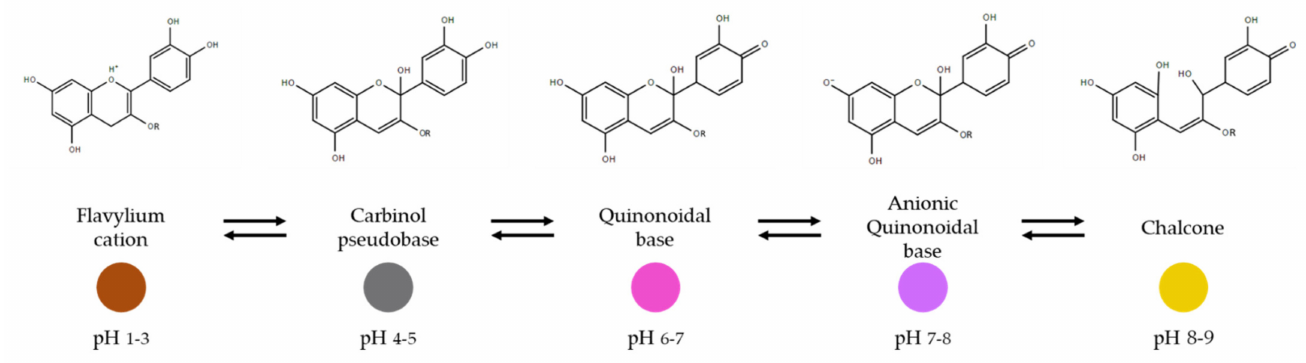
Figure 2. Changes in anthocyanins structure due to pH changes, adapted from [18].